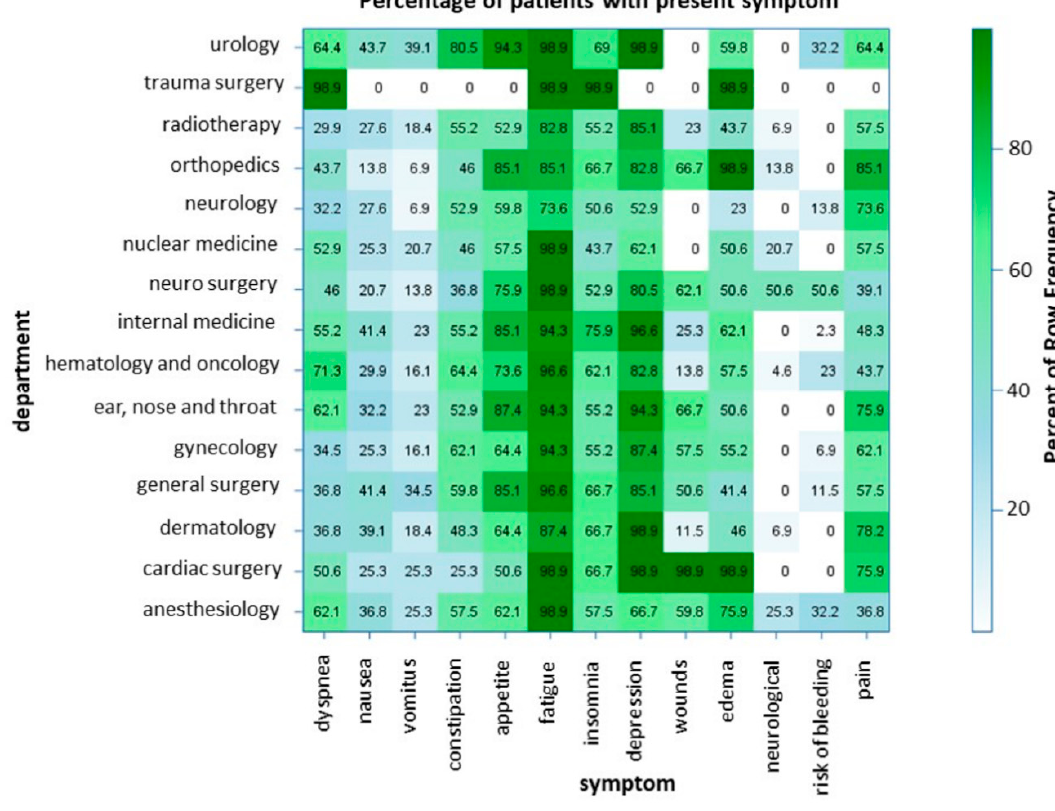
Figure 3. Correlation of the frequency of symptoms presented by patients referred to the PCCS and the respective departments.